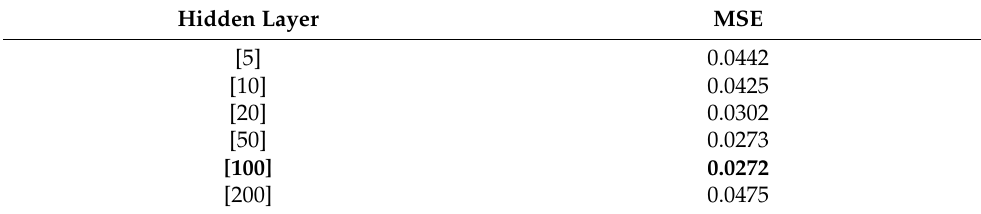
Table 2. MSE of the neural network with one hidden layer.